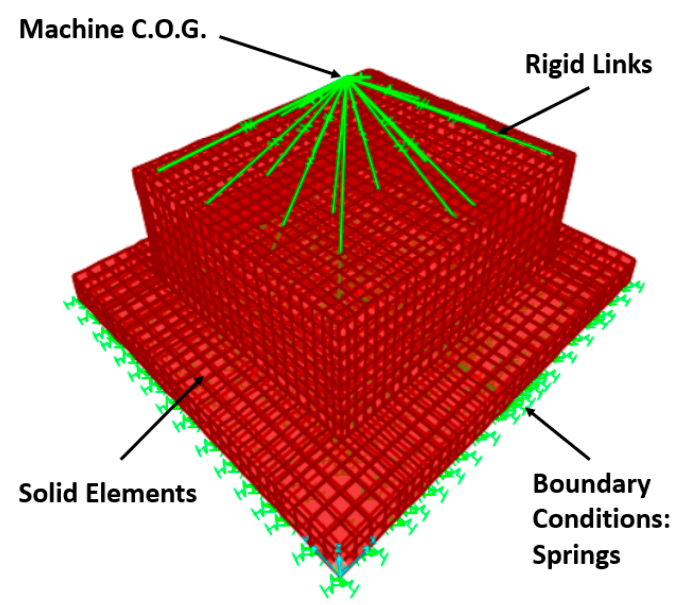
Figure 4. Finite Element Model.